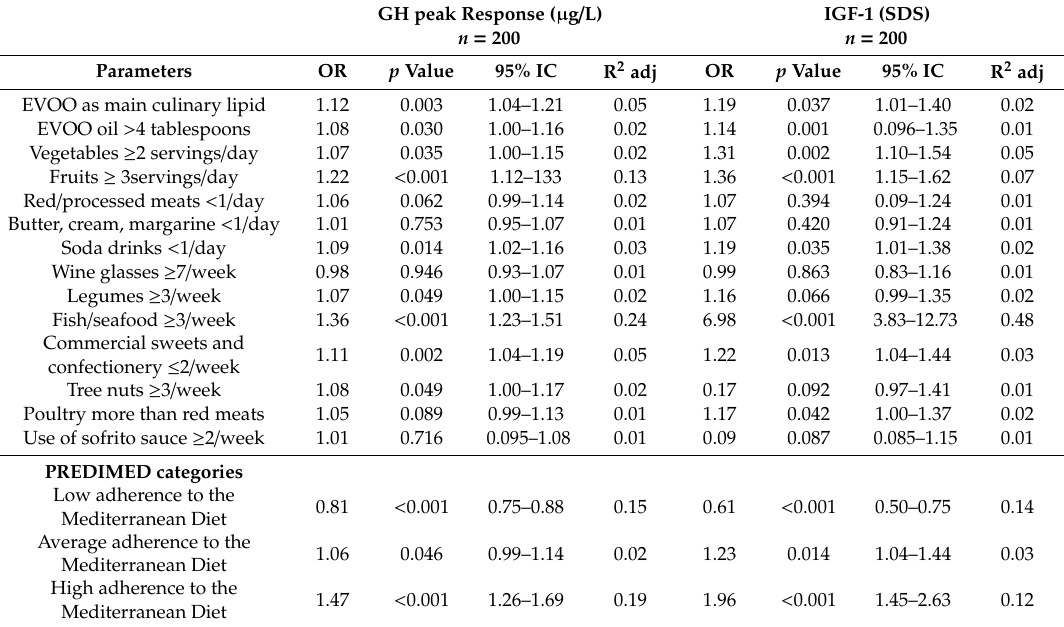
Table 7. Bivariate proportional odds ratio models performed to assess the association of GH peak response and IGF-1 SDS with the dietary components included in the PREDIMED